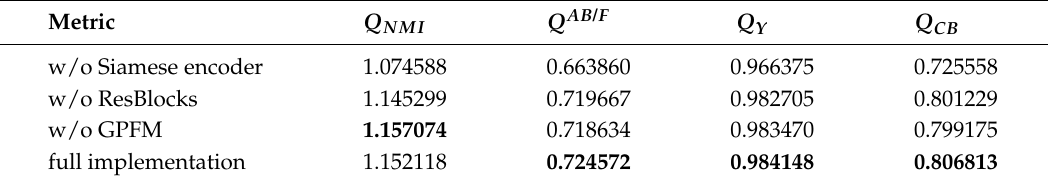
Table 2. The effectiveness of our different key components in the proposed model.